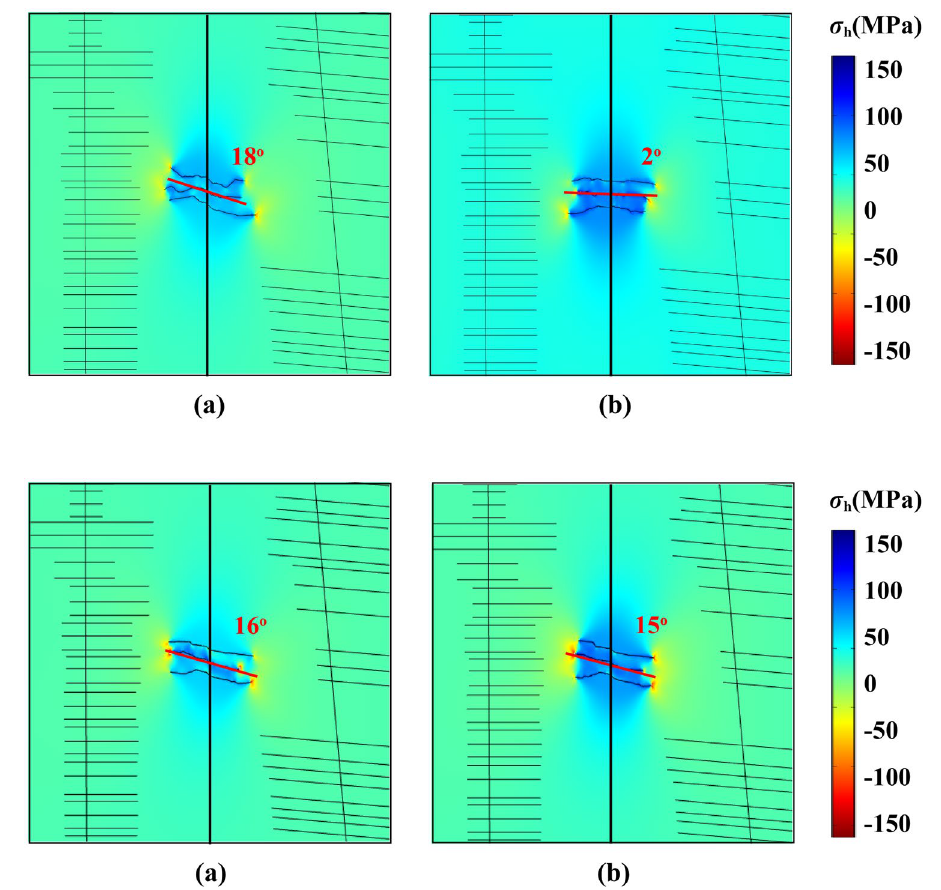
Fig. 17 Influences of the injec- tion volume on the fracture configuration (the 16th stage of M-I2): a ξ i = 0.25, soaking for 0 days; b ξ i = 0.5, soaking for